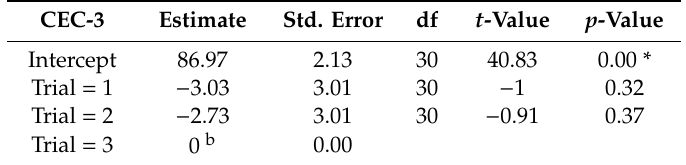
Table 4. Significant di ff erences among mean scores obtained per trial in CEC-3. CEC-3 Estimate Std. Error